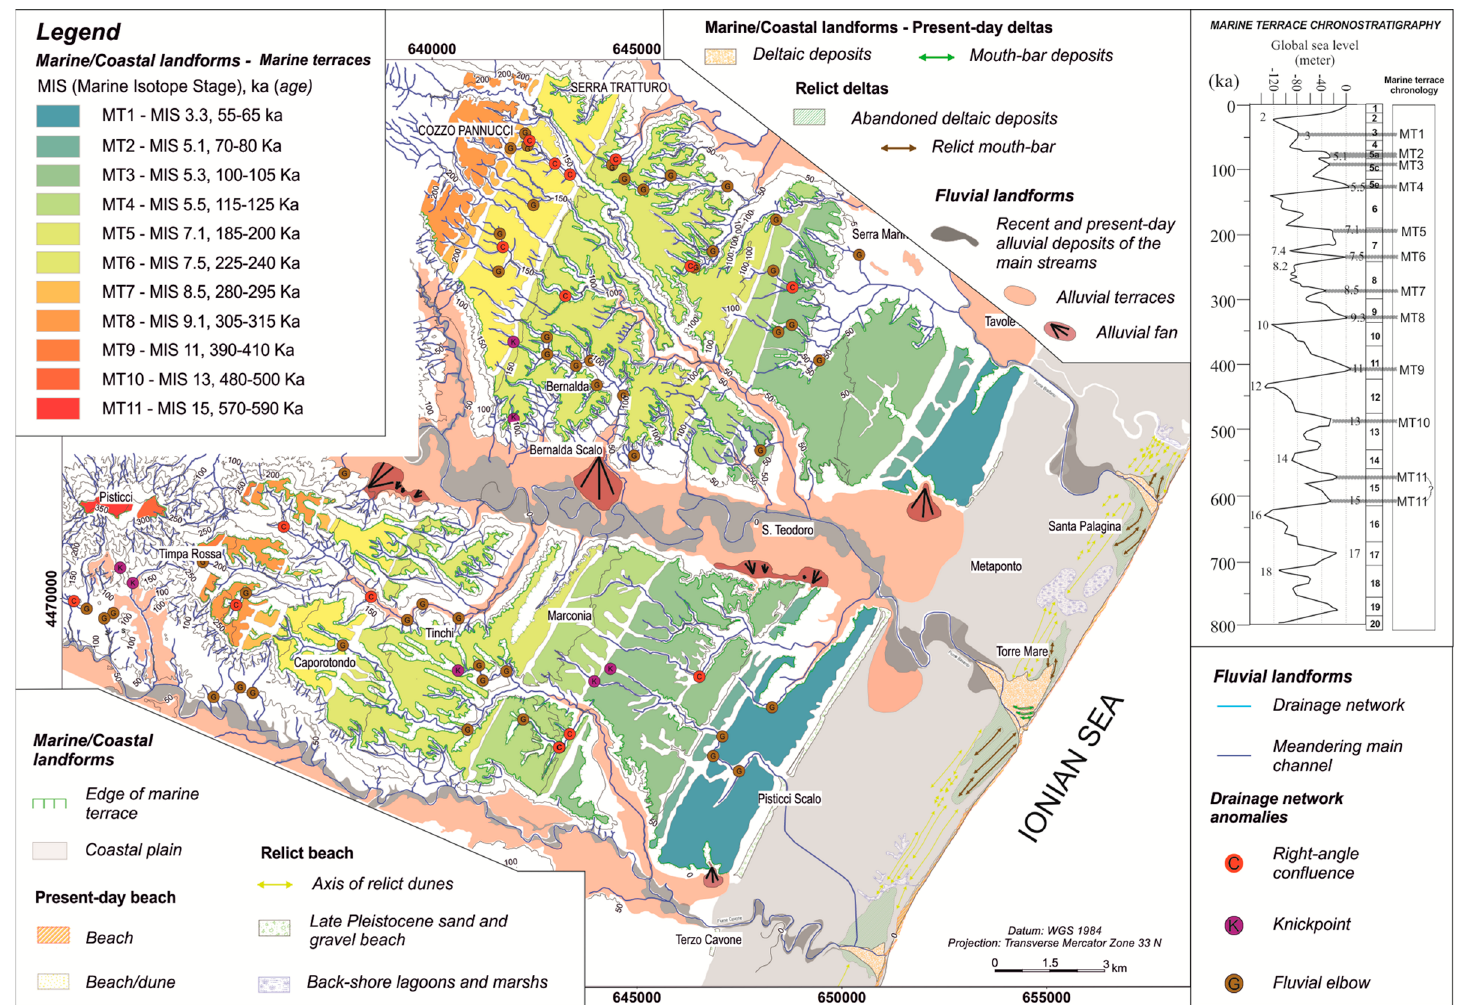
Figure 2. Geomorphological map of the study area and chronostratigraphy of the staircase of marine terraces (mod. after [23,24]).